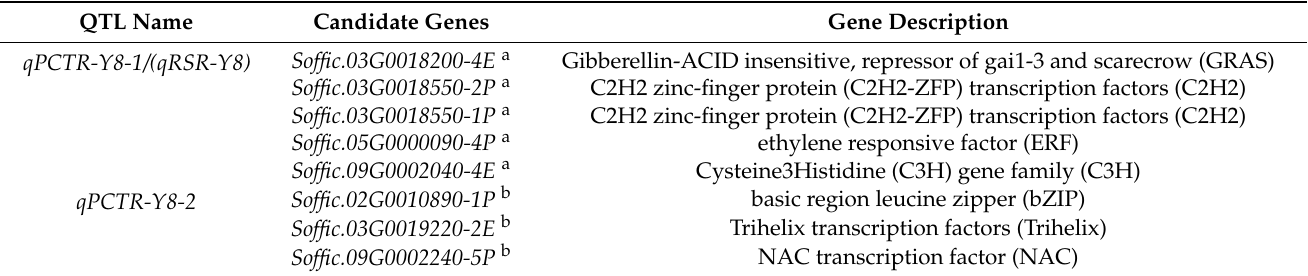
Table 4. Functional annotation of the transcription factor genes related to sugarcane tillering and